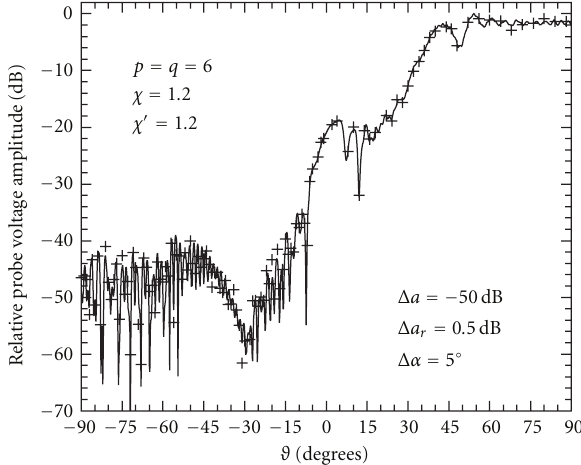
Figure 14: Amplitude of the output voltage V (cid:2) on the meridian at ϕ = 90 ◦ . Solid line: exact. Crosses: interpolated from error-a ff ected